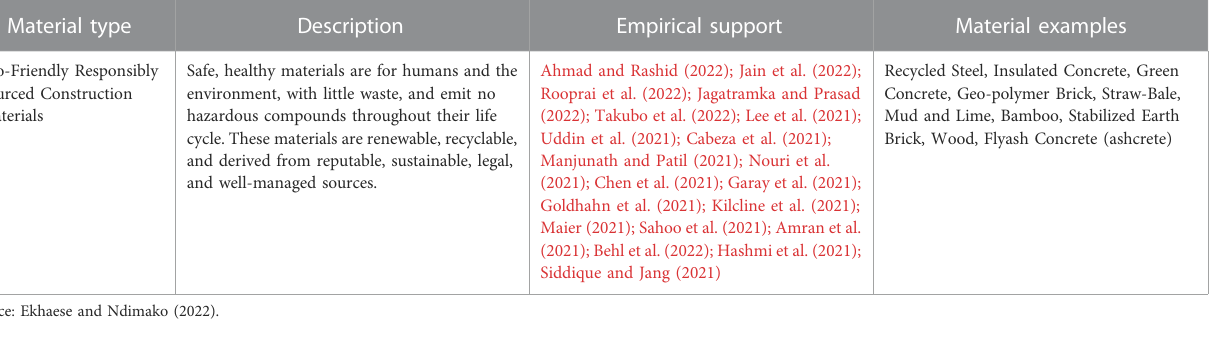
TABLE 3 Eco-friendly building materials contribution toward SDGs ’ attainment and their health bene fi ts. Sustainable development goals (SDGS)